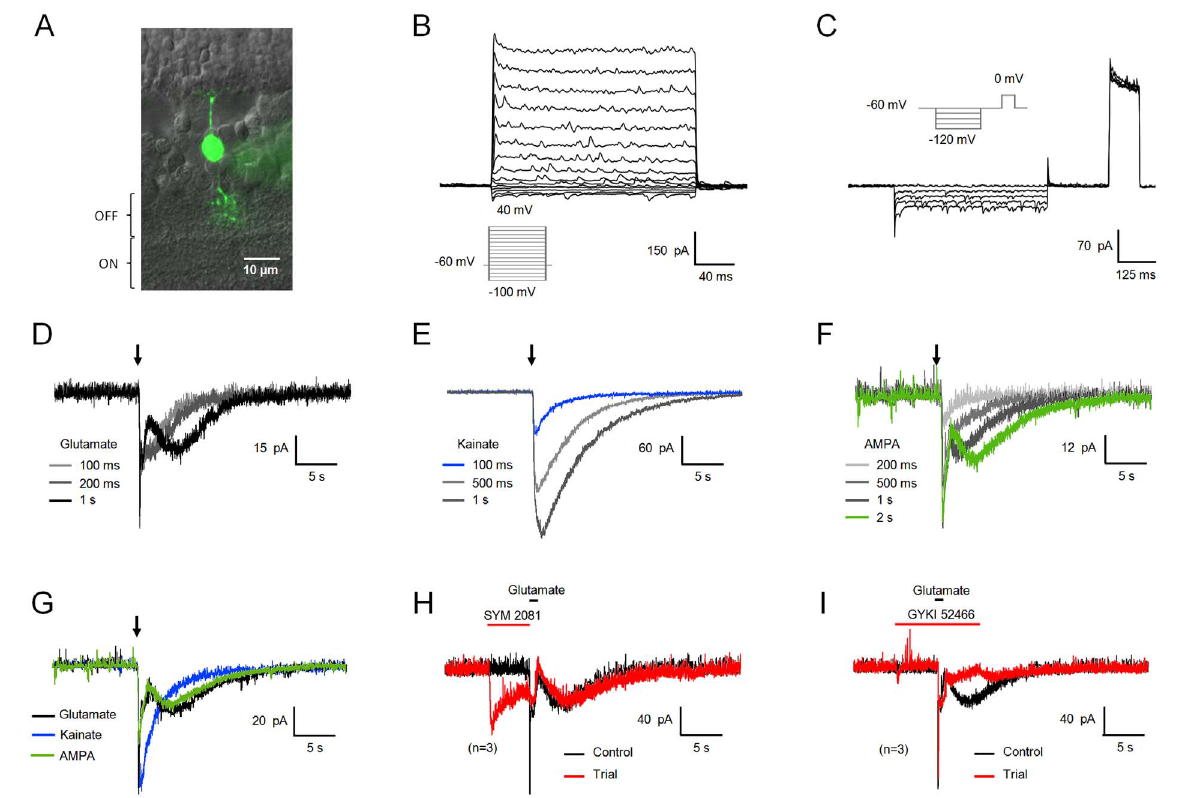
Figure 1. The glutamate response of type 4 CBCs consists of a fast, kainate receptor-, and a slow, AMPA receptor-dependent component. (A) Type 4 CBCs were identified by morphology, notably the position of their axonal endings in substrata 1 and 2 of the IPL, and by their characteristic voltage-gated currents (B, C). These cells lack hyperpolarization-activated cyclic nucleotide-gated (HCN) currents [23]. (D) Glutamate stimuli (500 m M), applied as puffs to the OPL, triggered biphasic inward currents at –60 mV, consisting of a fast peak followed by a slowly decaying tail. At longer stimulus durations, the response current becomes separated into a fast initial peak and a slow secondary component, carrying the bulk of the transferred charge. (E) Kainate stimuli (100 m M) of increasing durations triggered monophasic responses of larger amplitude and longer duration, without development of a separate slow response component. (F) AMPA (300 m M), which activates both AMPA and kainate receptors [32], elicits a two-component response at longer stimulus durations, similar to glutamate. The fast component is present at all stimulus durations. (G) At concentrations adjusted for comparable electrical charge transfer, glutamate (1 s,) and AMPA (2 s,) triggered similar biphasic responses, contrary to kainate (100 ms). (H) The kainate receptor-selective agonist SYM 2081 (50 m M) [63] abolished the fast component of the glutamate response in type 4 CBCs, while the slow component remained unaffected. (I) GYKI 52466 (30 m M), a selective AMPA receptor antagonist [64], blocked the slow component of the glutamate response, without affecting the fast, kainate receptor-dependent component.